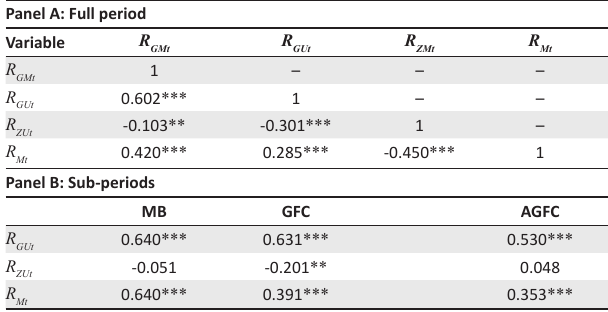
TABLE 1: Descriptive statistics for the data set (January 2006 to December 2013).